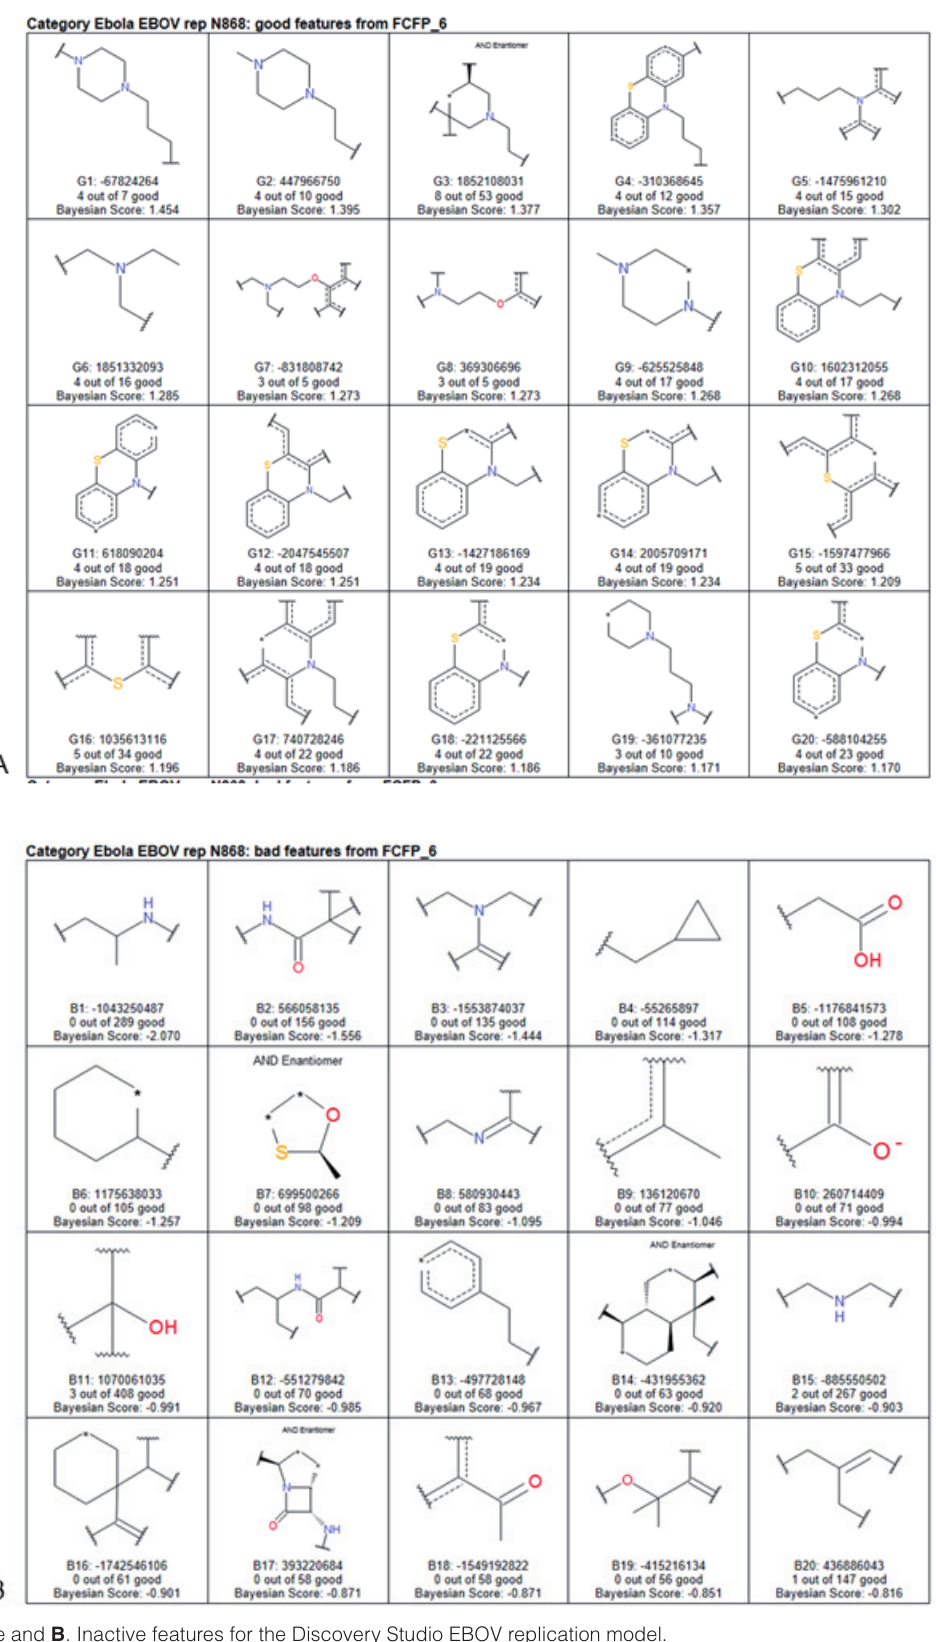
Figure 2. A . Active and B . Inactive features for the Discovery Studio EBOV replication